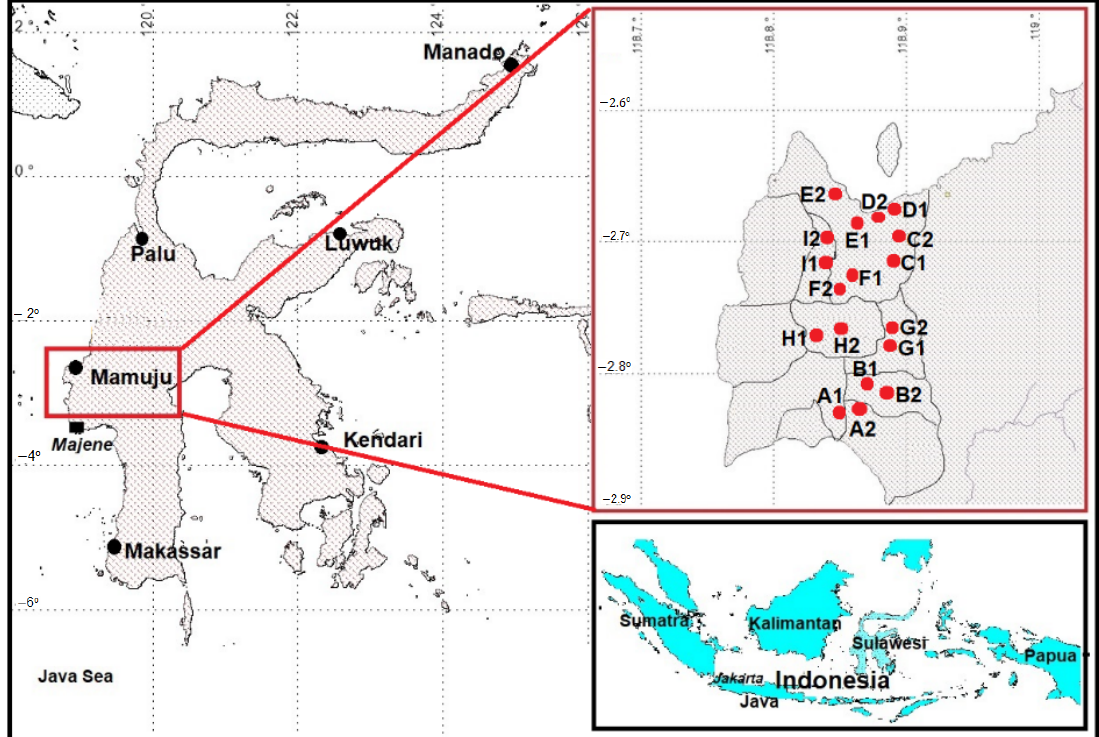
Figure 1. Study area. The red dots represent the sample sites used in this study, and the black dots represent the capital cities of Indonesian provinces.